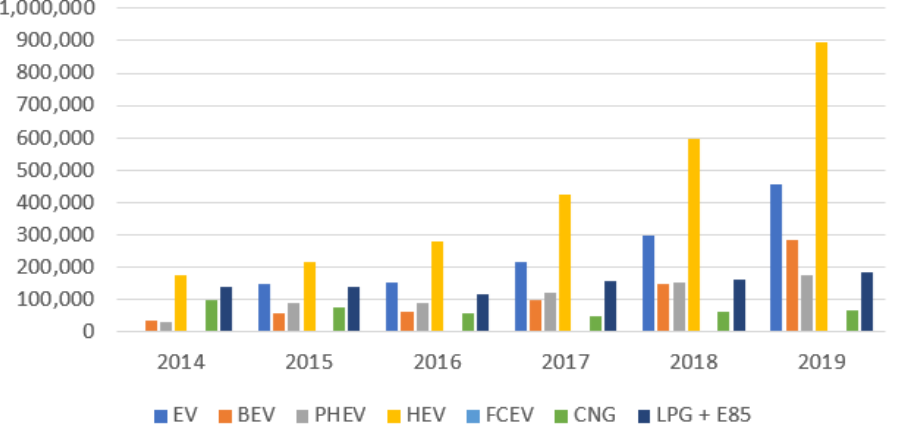
Figure 1. The share of innovative motor vehicles in 2014–2019 in Poland [1]. Where: EV—Electric Vehicle, BEV—Battery Electric Vehicle, HEV—Hybrid Electric Vehicle, PHEV—Plug-in Hybrid Electric Vehicle, FCEV—Fuel Cell Electric Vehicle, CNG—Natural Gas, LPG + E85—Other.